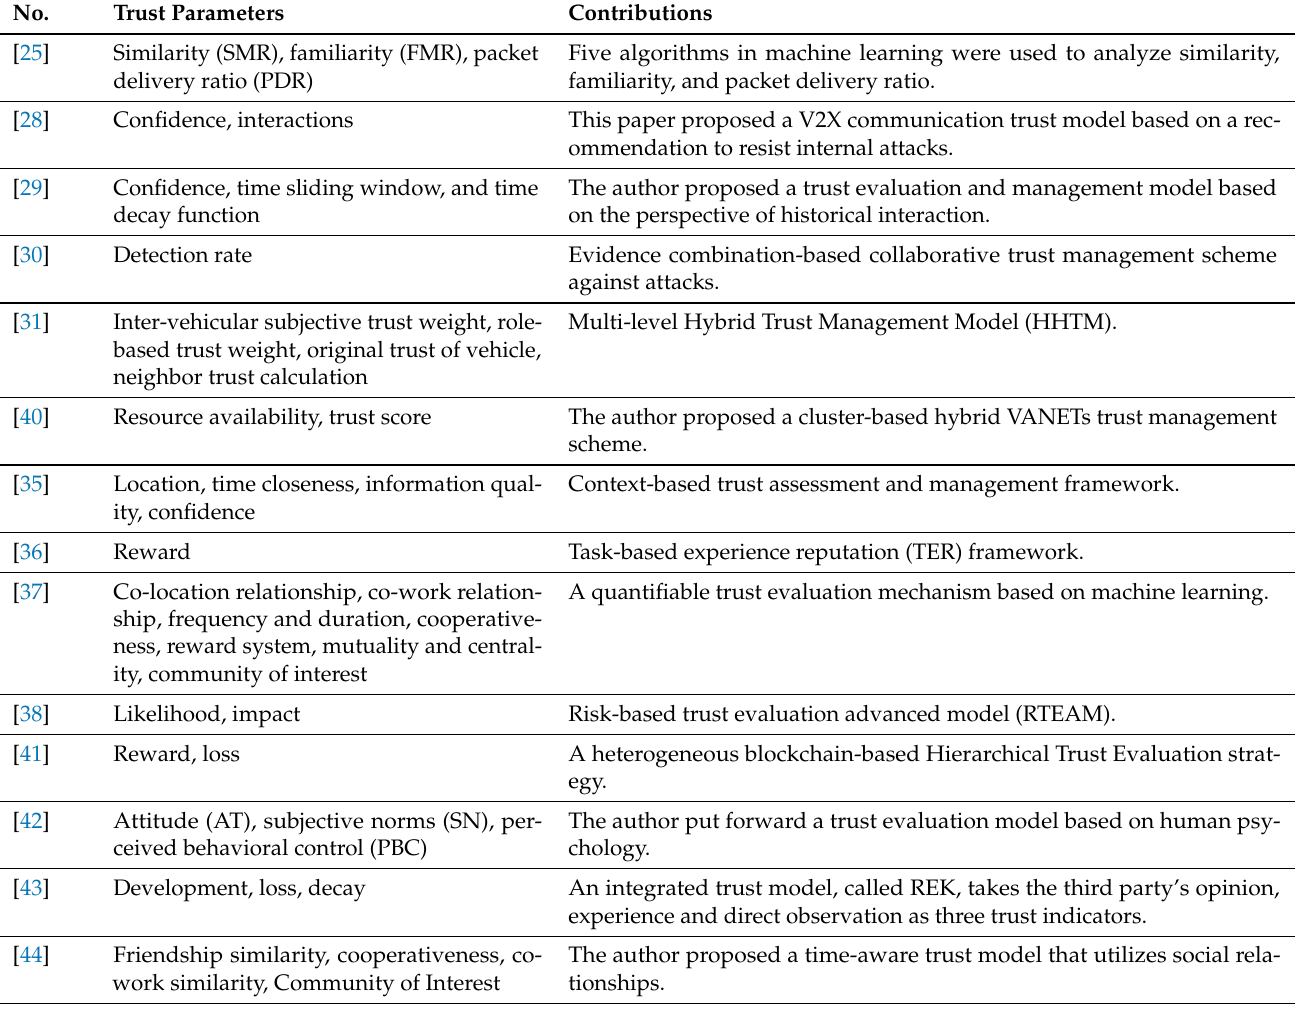
Table 3. A comparison of the existing state-of-the-art